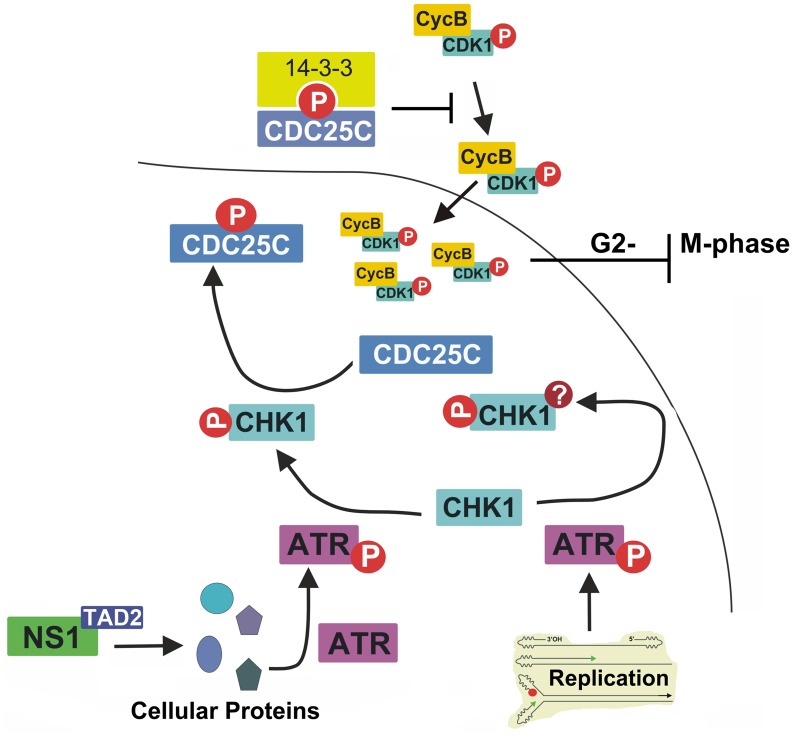
Proposed model for B19V NS1-induced G2-phase arrest.NS1 activates ATR through its TAD domain. Activated ATR then transduces signals to CDC25C through activating CHK1. CDC25C phosphatase activity is negatively regulated by phosphorylation at serine 216, which then creates a binding site for the 14-3-3 protein in the cytoplasm [41]. Thus, inactive CDC25C cannot dephosphorylate the cyclin B1/CDK1(pT14/Y15) complex; the latter component is inactive, and so progression from G2- to M-phase is blocked. It is proposed that DNA replication-induced DDR, and thereafter ATR/CHK1 activation, which plays a role in viral DNA replication, should not be involved in CDC25C phosphorylation (see the Discussion section for further explanation). The question mark indicates potential modification of CHK1, in addition to the phosphorylation at S345.